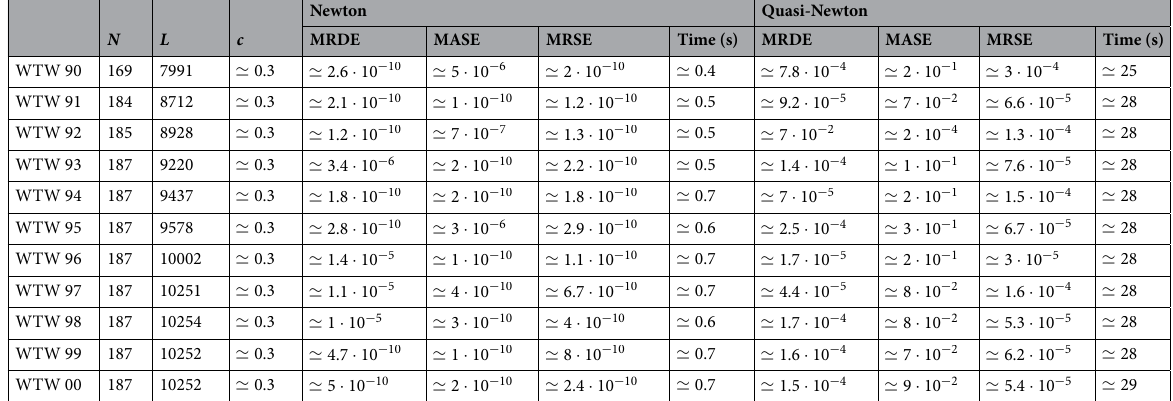
Table 4. Performance of Newton’s and the quasi-Newton method to solve the reduced system of equations defining the UECM, on a set of real-world WUNs (of which basic statistics as the total number of nodes, N , the 2 L / N ( N 1 ) , are provided). While Newton’s method stops total number of links, L , and the connectance, c = − 8 L ( 10 θ) because the condition is satisfied, the quasi-Newton one always reaches the limit of 10000 2 − � ||∇ || ≤ steps. The results on accuracy and speed clearly indicate that Newton’s method outperforms the quasi-Newton one. Only the results corresponding to the best choice of initial conditions are reported. The results of the fixed-point recipe are not